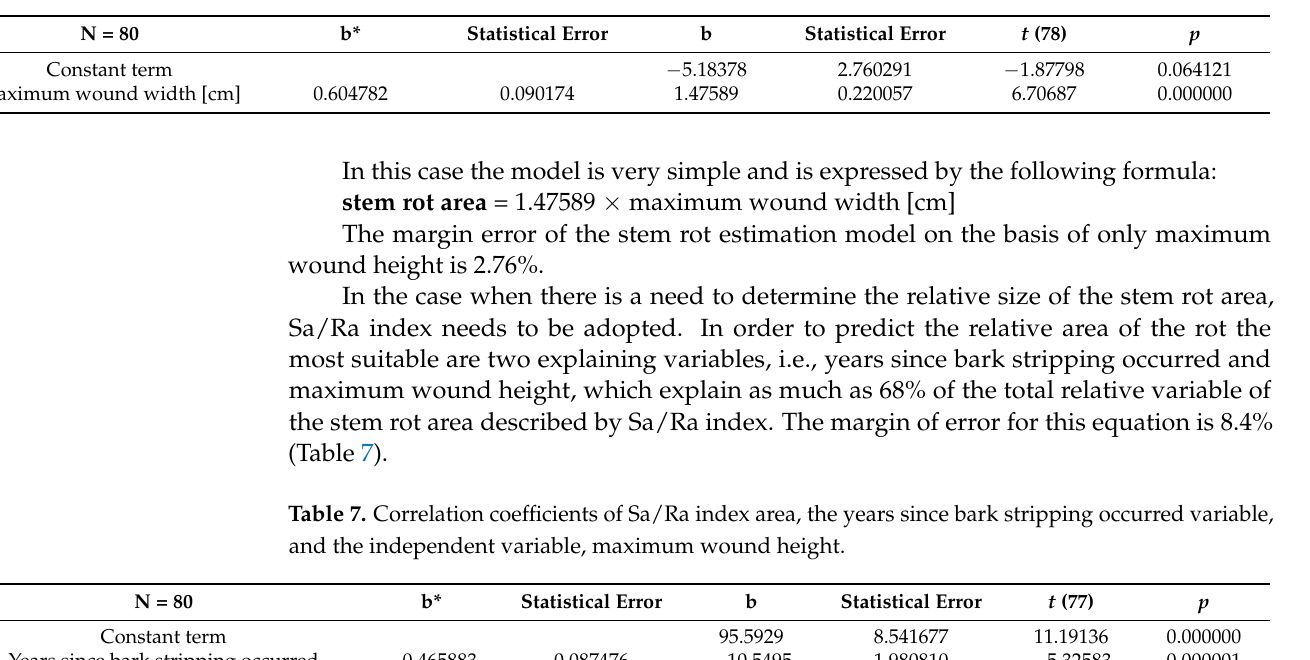
Table 6. Correlation coefficients of stem rot area and the independent variable maximum wound width.